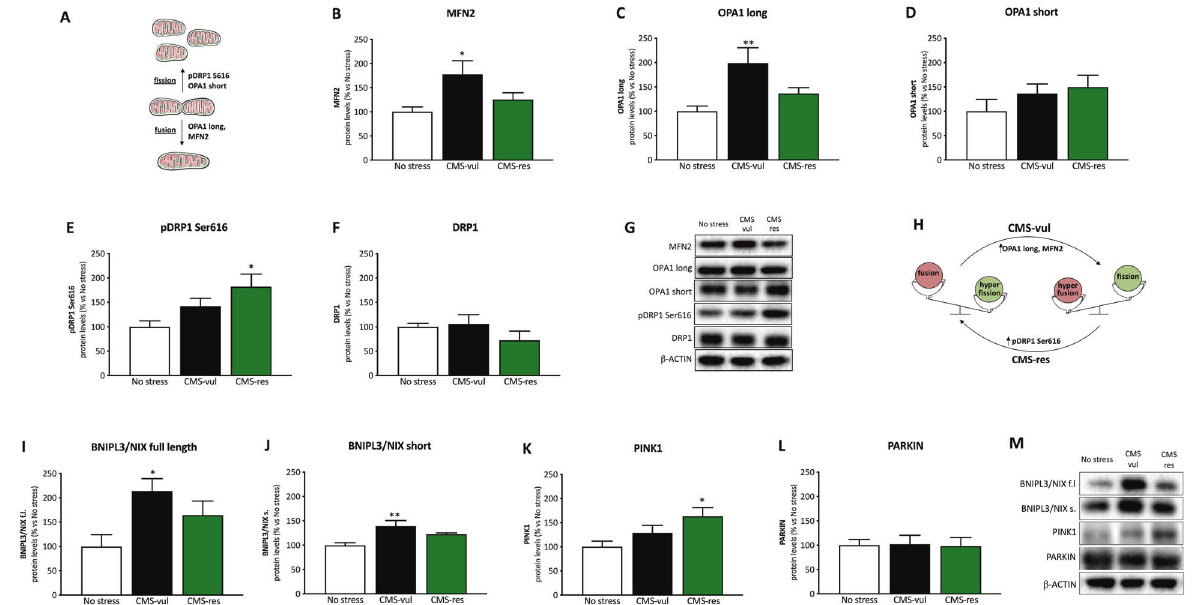
Fig. 5 Analysis of fusion, fi ssion and mitophagy markers in the vHip of vulnerable and resilient animals to CMS. A Schematic representation of the fusion and fi ssion core machinery; Fusion ( B – D ), fi ssion ( E , F ) and mitophagy ( I – L ) markers protein levels. The data are the mean ± SEM; G , M representative WB blots; H : schematic illustration of the mitochondrial dynamics unbalance. * P < 0.05, ** p < 0.01 vs no stress (one-way ANOVA with Fisher ’ s